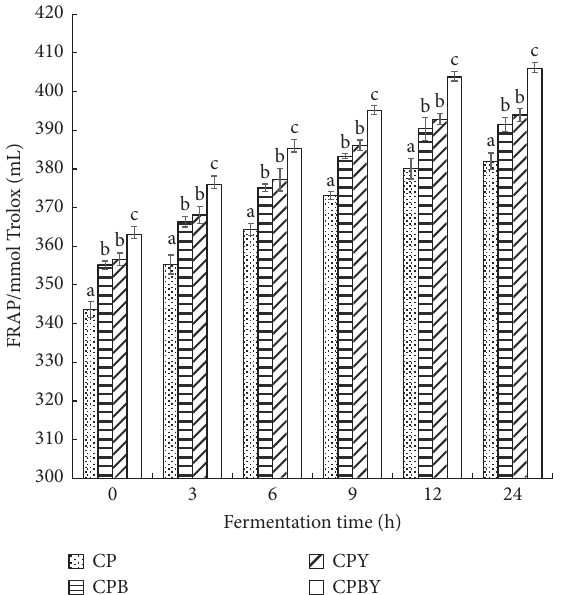
Figure 6: FRAP antioxidant capacity of four samples at different fermentation times. All the values are expressed as mean ± SD ( n � 3). Means with different lowercase letters indicate a significant difference of four group samples at the same fermentation time ( p < 0 . 05). CP, chickpea fermentation milk; CPB, chickpea fer- mentation milk with enzyme hydrolysis; CPY, chickpea yam fer- mentation milk; CPBY, chickpea yam fermentation milk with enzyme